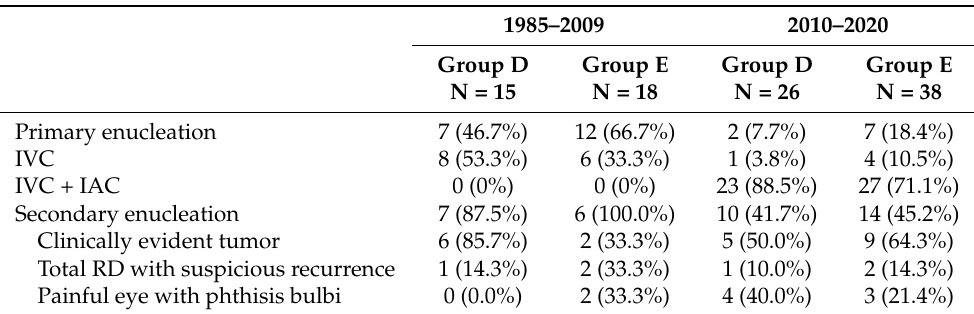
Table 2. Summary of the distribution of patients and the reason for enucleation in advanced retinoblastoma